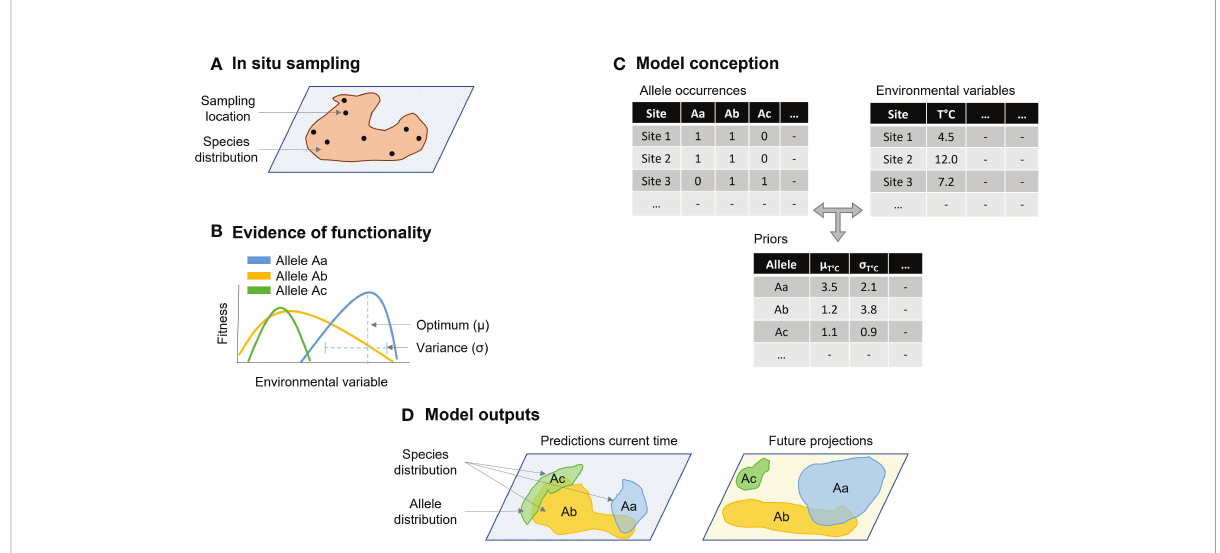
FIGURE 1 Conceptual eco-evolutionary framework adapted from a Bayesian joint-species distribution model (J-SDM) to estimate species distribution from allele occurrence patterns and fi tness. The framework is divided in four steps, (A) fi sh sampling at spawning locations representative of the species distribution, (B) identi fi cation of the candidate genes and if possible, empirical assessment of allele reaction norm for a focal environmental variable, (C) model conception based on allele occurrence and environmental conditions at sampling sites, using optimum and variance of the reaction norm to inform prior distributions and phylogenetic trees to identify similarities between sampled locations genetic composition to characterize allele cooccurrence patterns, and (D) explain allele relationships with environmental variables, predict allele distributions and eventually forecast species spawning distribution as the stacked allele distributions changes in response to environmental variable